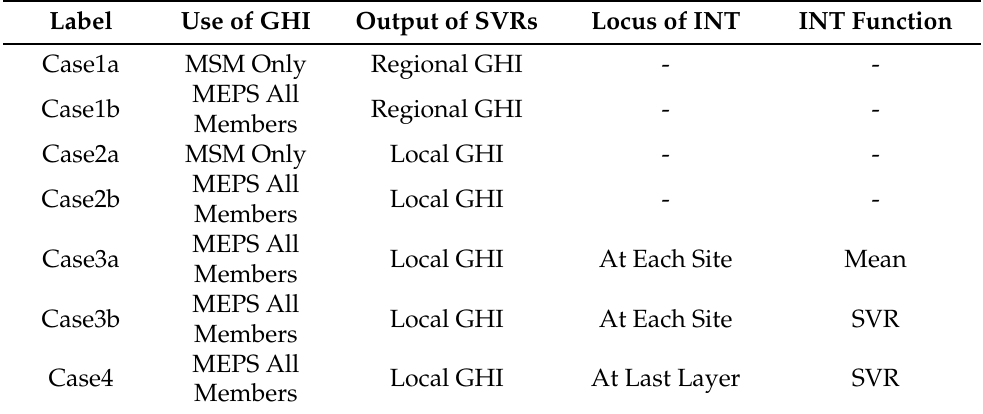
Table 1. Classification of prediction models.